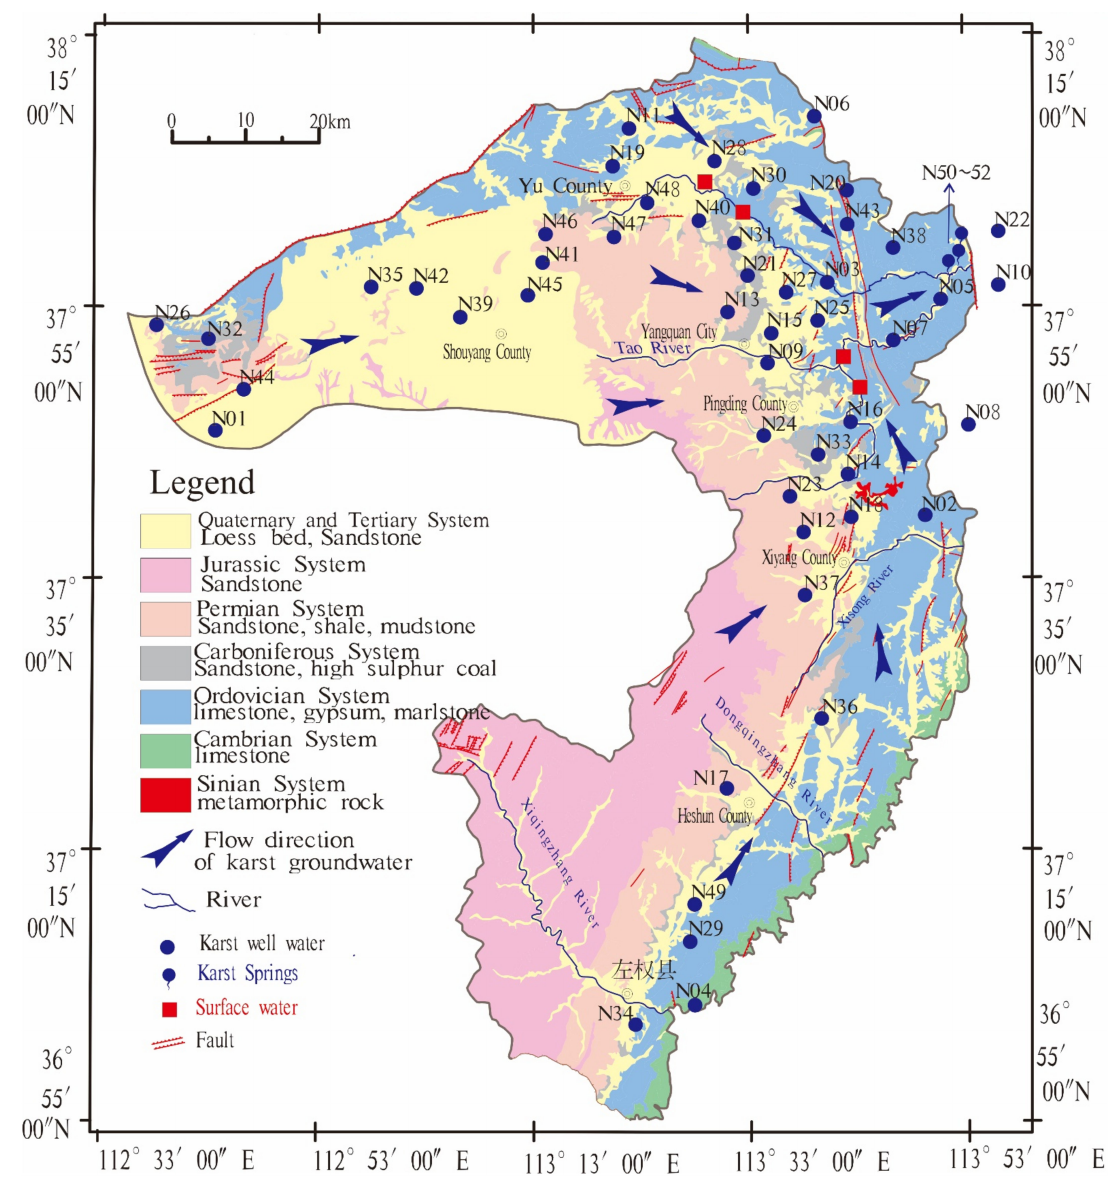
Figure 1. Hydrogeological map of Niangziguan spring